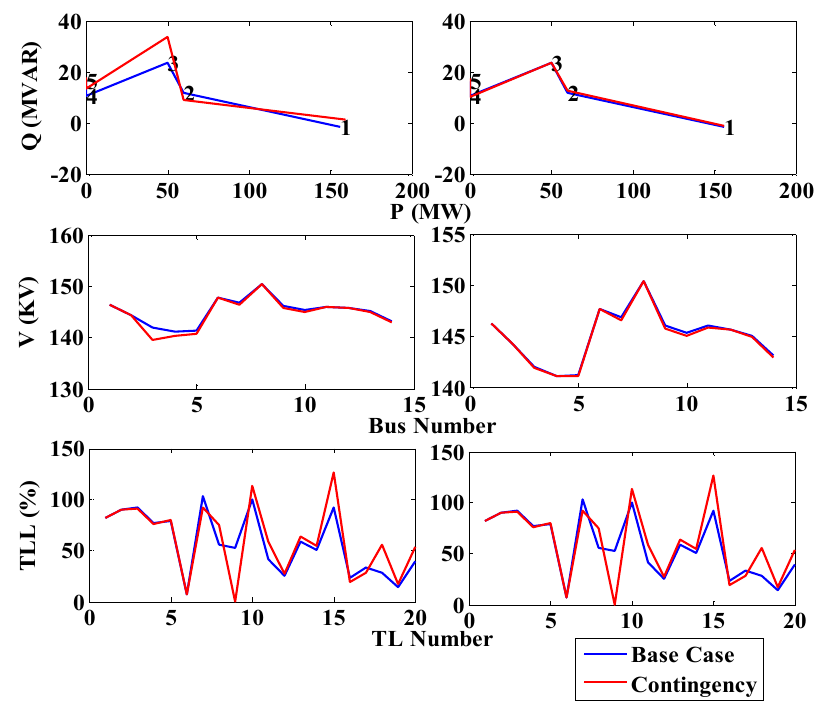
Figure 5. ( Left Column ) Comparison of P and Q , V , and TLL of a Malicious Case to the Base Case; ( Right Column ) Comparison of P and Q , V , and TLL of an Alert Case to the Base Case.